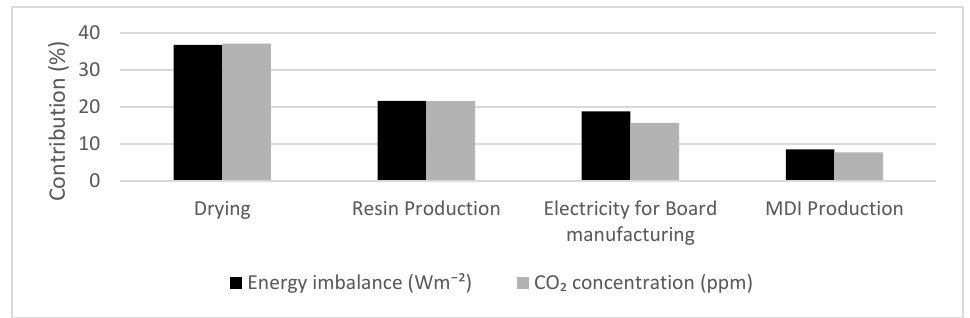
Figure 5. Main environmental hotspots contributing to the CC-EI, and CC-CO 2 impact category.